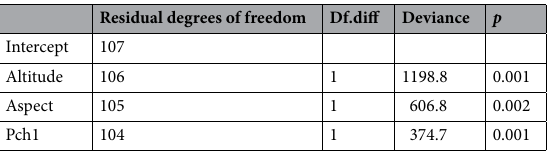
and vertical vegetation structure, mean or minimum temperature. One model included season, and another included a measure of soil (Table 3). The best model obtained from model averaging found that sesFD was sig- nificantly lower on the southern aspect relative to the north, and was higher with increasing mean and minimum temperatures; however, the microclimate provided by vegetation in this setting also appears to be key: functional differentiation decreased with pch1 and pcv2, in other words, functional diversity increased with higher vegeta- tion cover in the lower stratum and decreased when vegetation structure at higher strata became more complex. sesFD also increased with soil sandiness. The best-averaged model was: